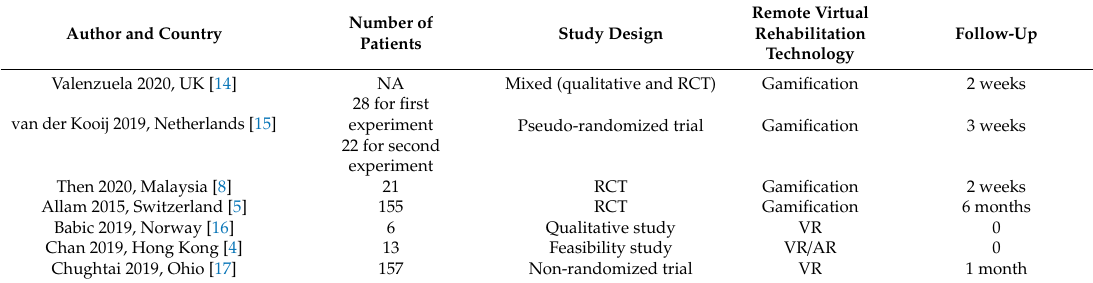
Table 1. Characteristics of the included studies.